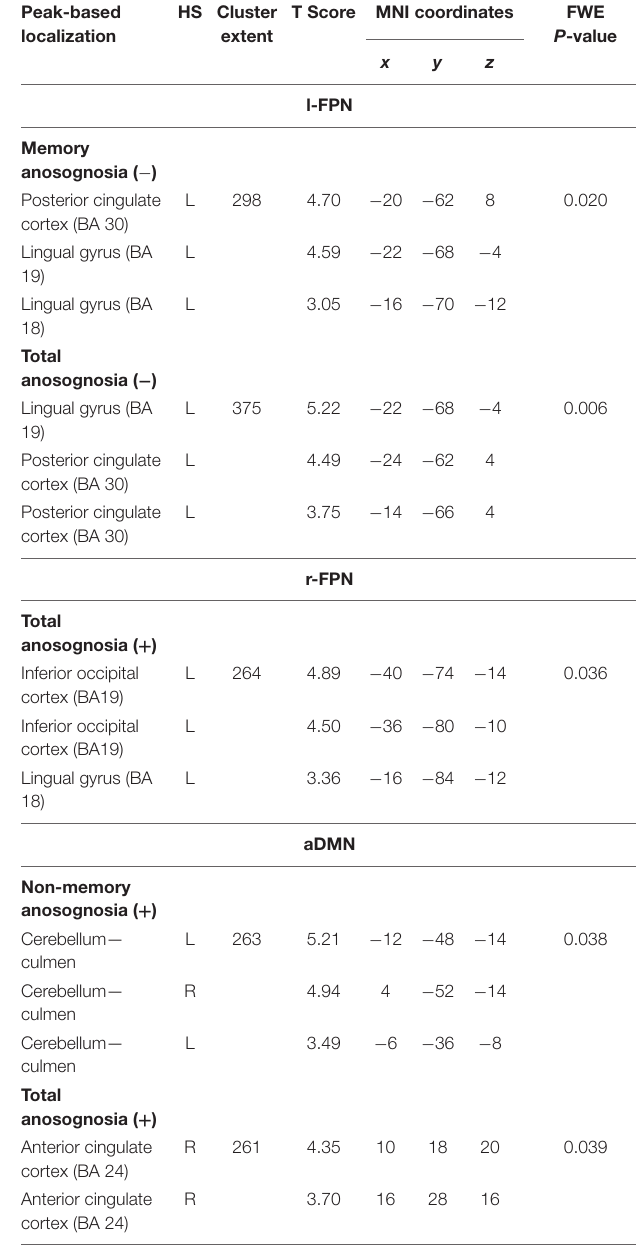
TABLE 2 | Results emerging from large-scale brain functional networks obtained via independent component